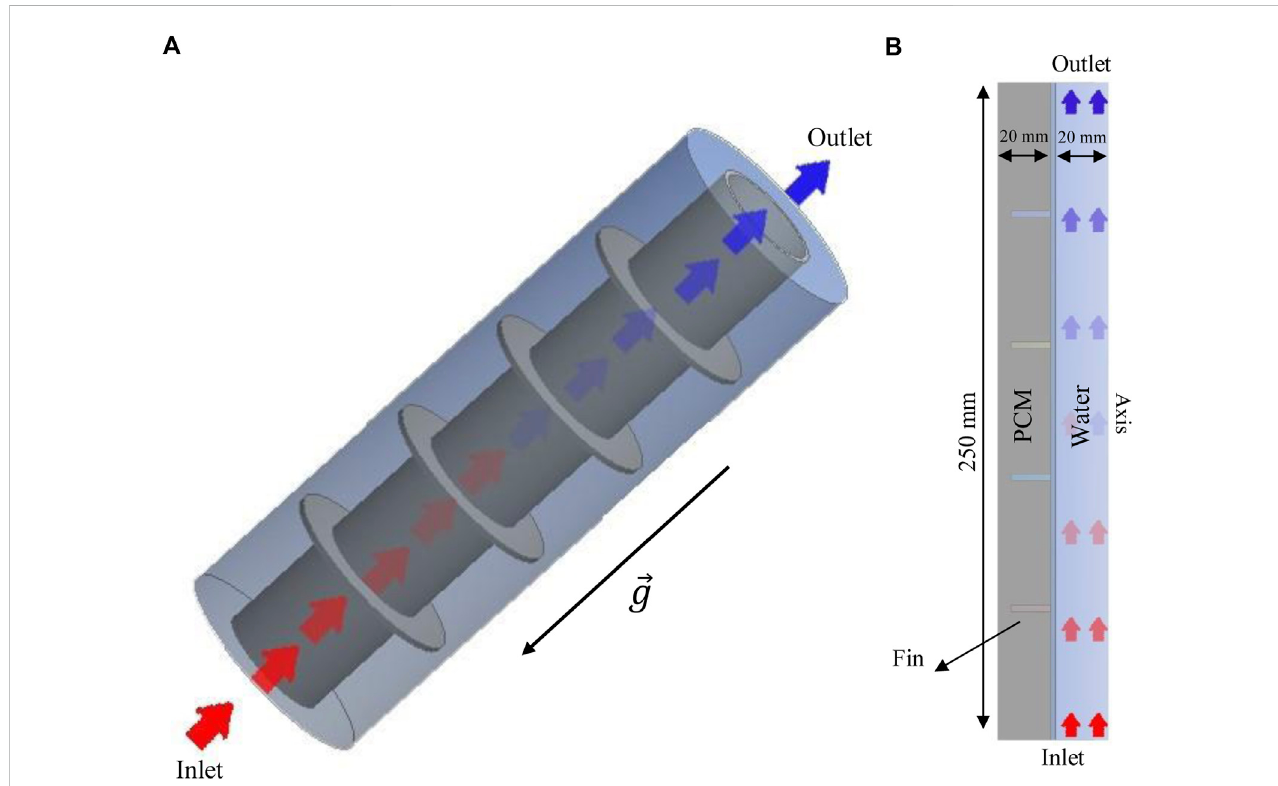
FIGURE 1 Schematic of the system presented as three-dimensional (A) and two-dimensional (B) axisymmetric models.